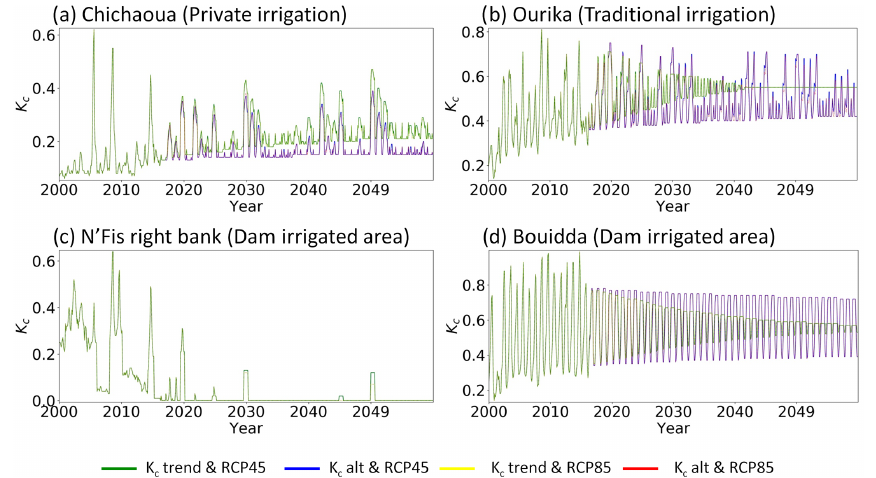
Figure 6. Examples of long-term simulation of K c in four different irrigated areas with the trend and alternative scenarios of K c and the RCP4.5 and RCP8.5 climatic